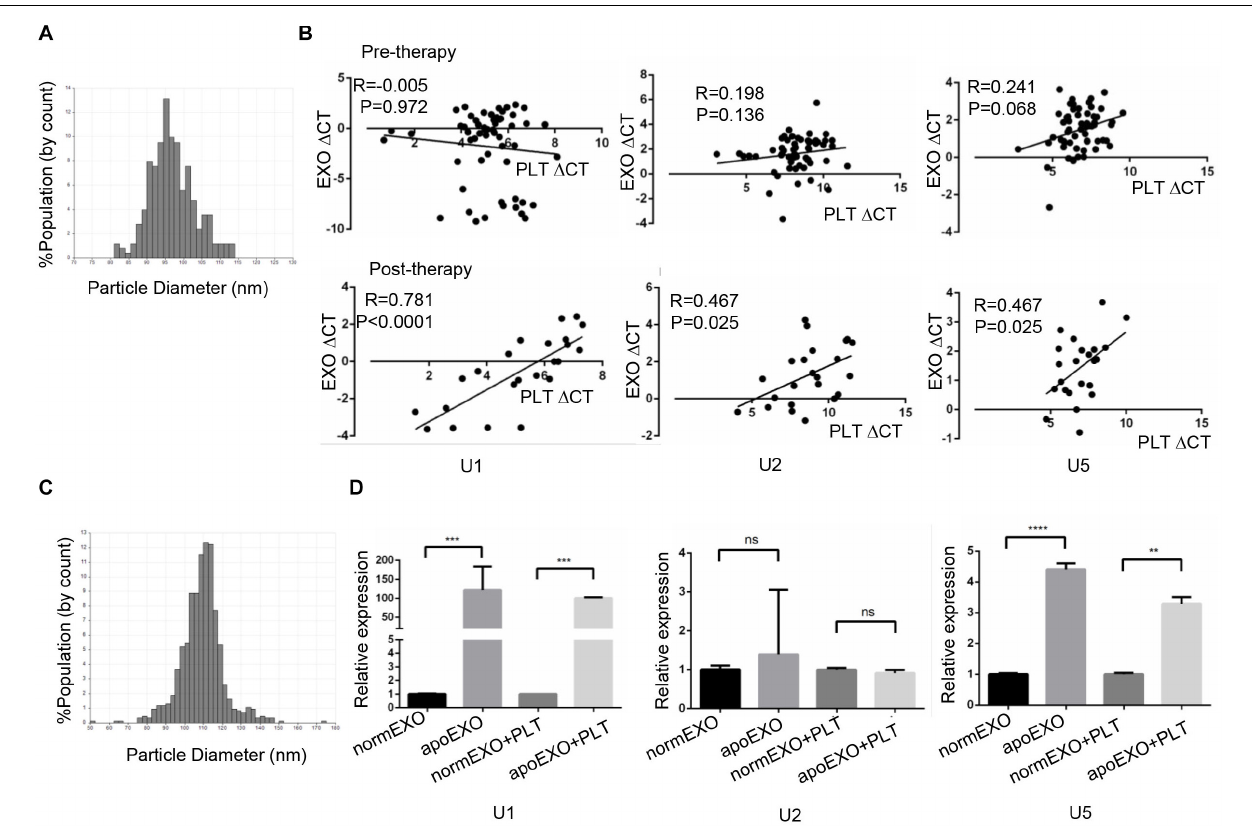
FIGURE 6 | TEP U1, U5 but not U2 expression was affected by apo-exosomes. (A) Distribution of exosomes of 50–150 nm diameter in the samples from lung cancer patients’ plasma based on the qNano system; (B) The correlations between U1, U2, U5 expression and platelet counts in 58 untreated patients (upper) and 20 treated lung cancer patients (down); (C) Distribution of exosomes of 50–150 nm diameter in the samples from A549 cells based on the qNano system; (D) Exosomal U1, U5 from apoptotic A549 cells (apoEXO) were significantly increased compared to those derived from normal A549 cells. normEXO/apoEXO, exosomes derived from normal/apoptotic A549 cells. ** p < 0.005; *** p < 0.001; **** p < 0.0001; ns, no